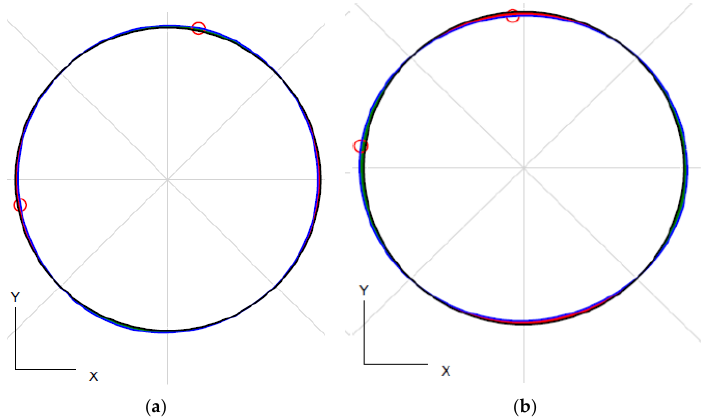
Figure 15. Roundness deviations ( a ) constant Z strategy; ( b ) circular pocket strategy.